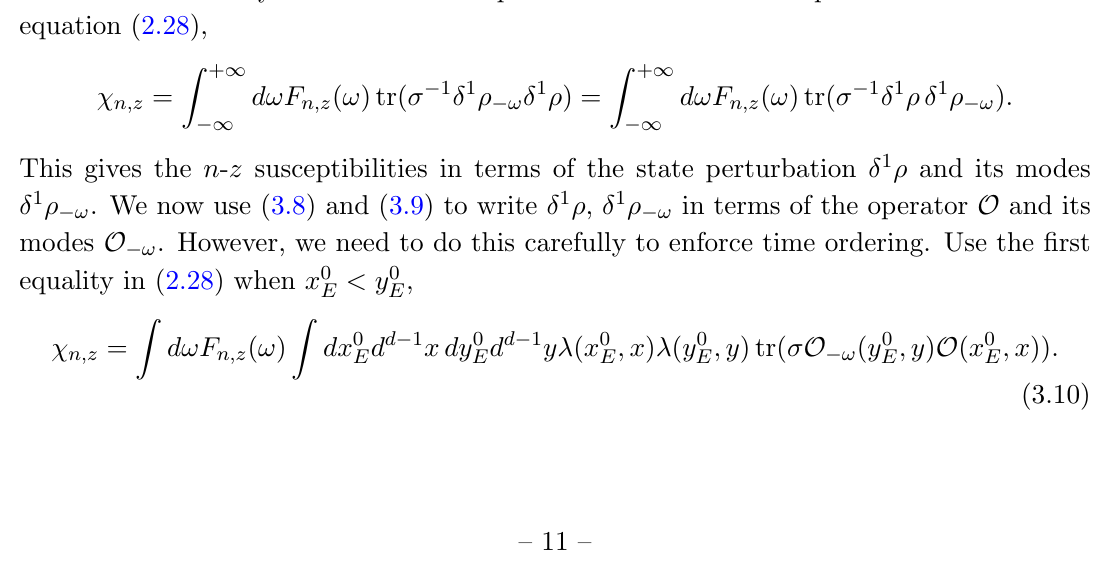
φ 1 Ψ . (b) The path integral given in equation (3.5) h | i